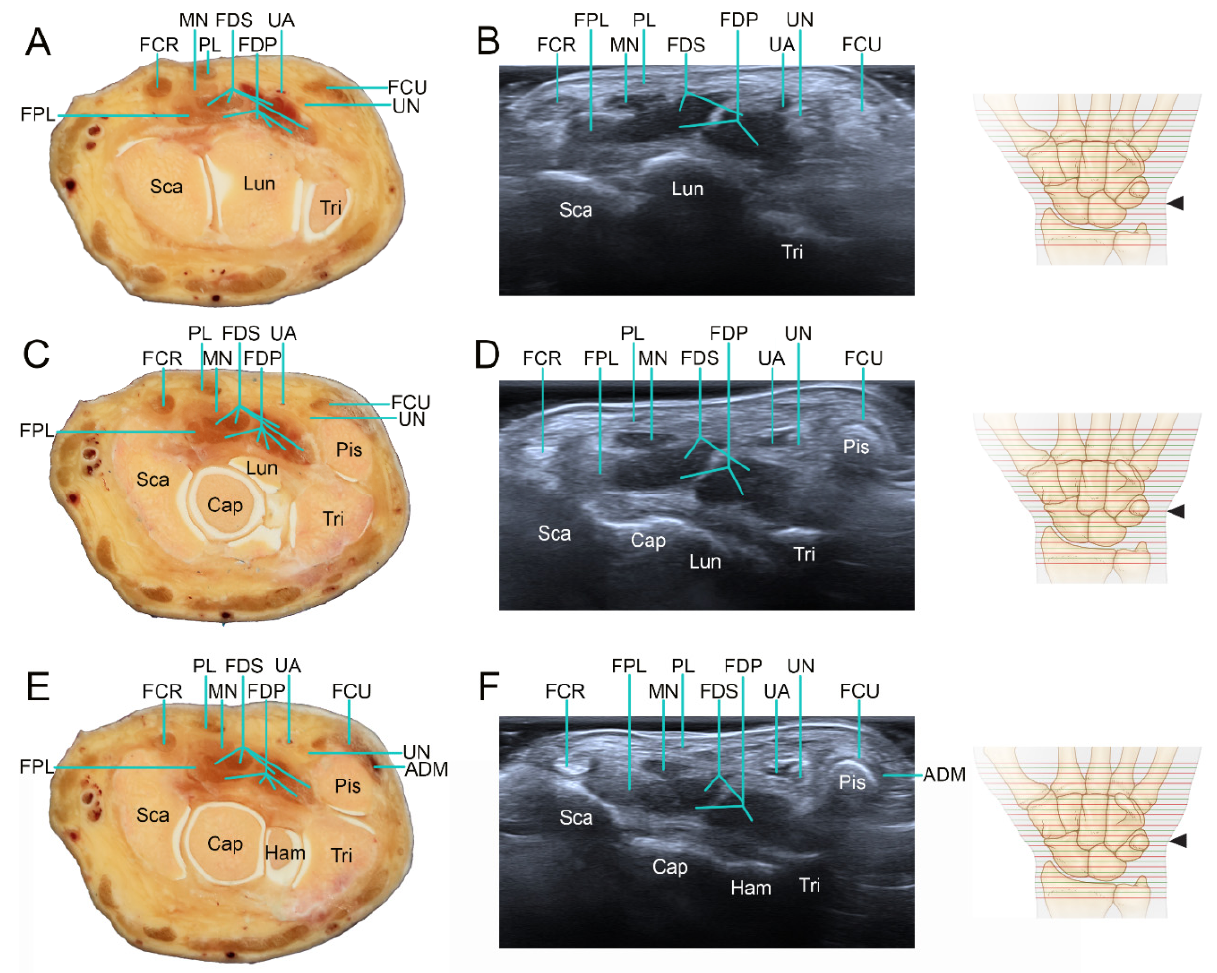
Figure 4. Sectioned images ( A , C , E ) and the corresponding US ( B , D , F ) images for transverse views at the proximal part of the proximal carpal bones. ( A , B ) At the proximal carpal bones, the Sca, Lun, and triquetrum (Tri) articulate with each other. The PL, FCR, and FCU tendons have constant sites and sizes. The MN is between the PL tendon and the second FDS tendon. The UA is just radial to the FCU tendon, and the UN is deep to the radial side of the FCU tendon. ( C , D ) At a more-distal level, the Sca becomes longer in the ventrodorsal direction. The pisiform (Pis) appears, and the Tri becomes larger. The capitate (Cap) appears between the Sca and Lun. The FCU tendon is just anterior to the Pis, and attaches to it. The MN is on the FPL and the second and third FDS tendons. The UA and UN are just radial to the Pis, and are anterior to the fourth and fifth FDS tendons. ( E , F ) At an even more-distal level, the round tubercle of the Sca is observed and is close to the FCR tendon. The Cap becomes larger, and the hamate (Ham) appears. The PL tendon becomes flat. The abductor digiti minimi (ADM) appears on the ulnar side of the FCU tendon. The MN is on the second and third FDS tendons, the FPL tendon, and is deep to the PL tendon. The UA and UN are just radial to the Pis and are anterior to the fourth and fifth FDS tendons. Arrowheads in the schematics indicate the levels of the wrist scanned by the US